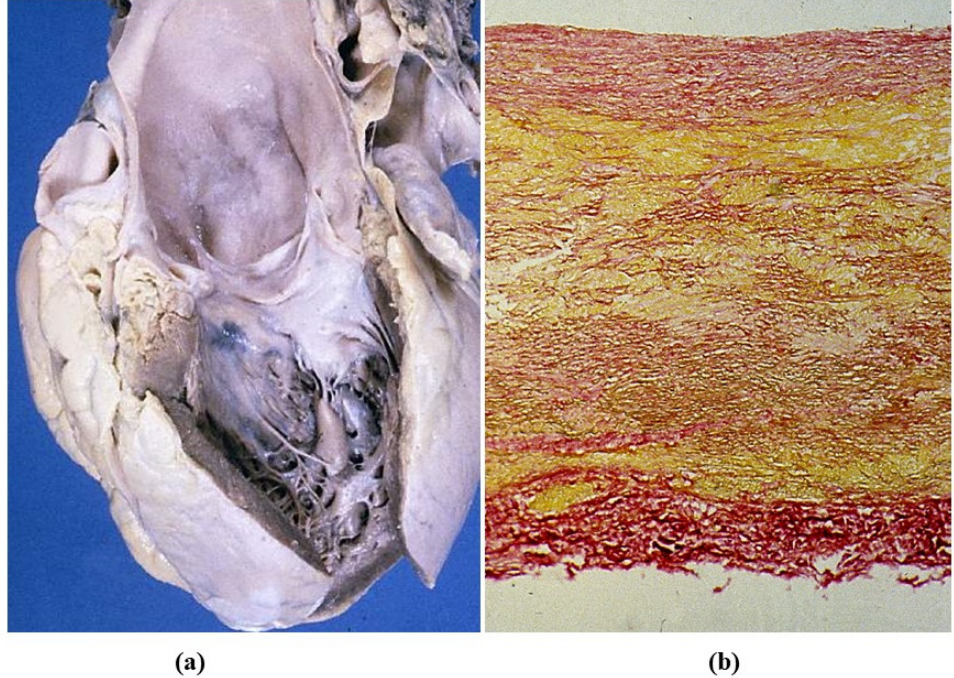
Figure 16. ( a ) Gross view of a dilated ascending aorta with aortic valve incompetence (anuloaortic- ectasia), due to degenerative disease of the aortic tunica media, not genetically determined. ( b ) Severe disruption of the elastic fibers in the tunica media. (Weigert Van Gieson stain).